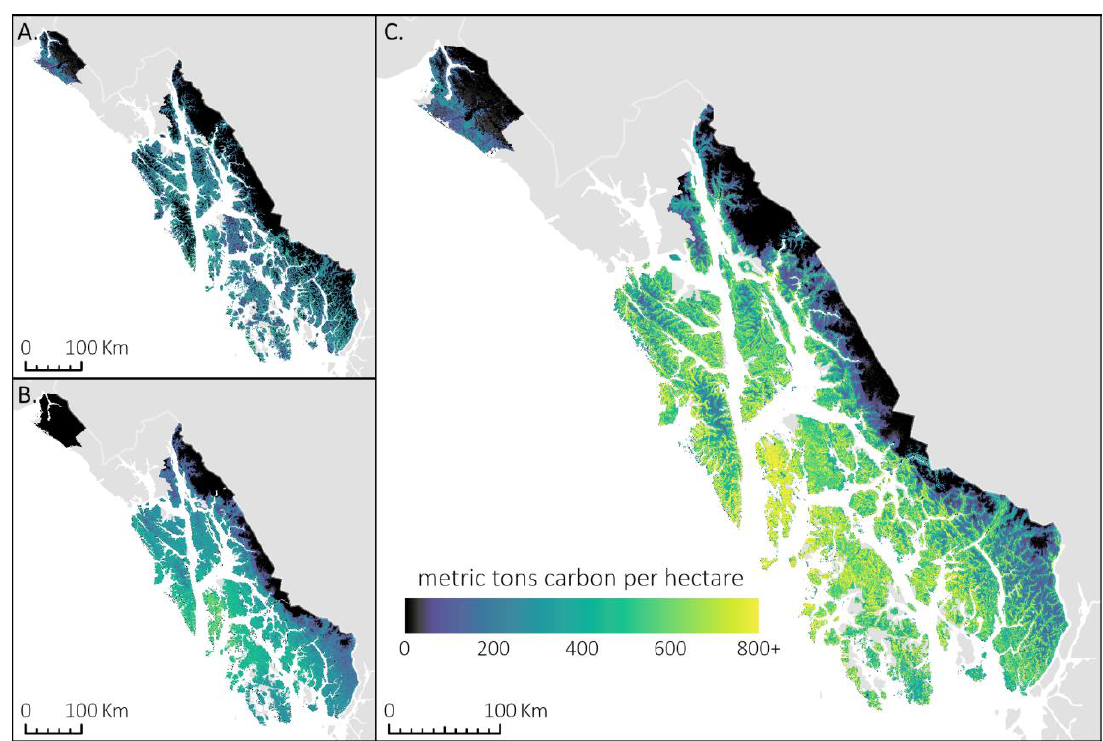
Figure 2. Spatial distribution of carbon (metric tons ha −1 ) stored in ( A ) woody plant biomass (carbon pools include trees, roots, woody debris, seedlings/saplings, dead snags, and understory vegetation), ( B ) soil organic matter (top 1 m of mineral soil plus surface organic horizons), and ( C ) the sum of biomass and soil in the Tongass National Forest.